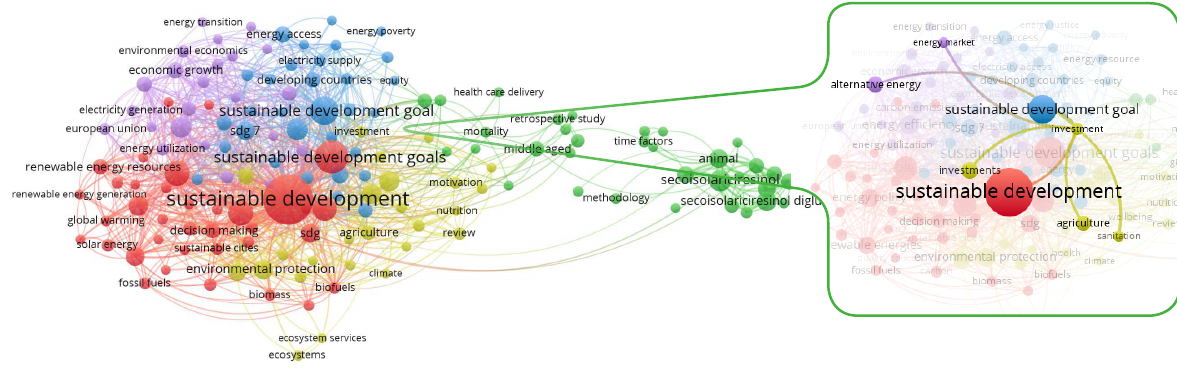
Figure 4. Co-occurrence map of SDG 7 publications